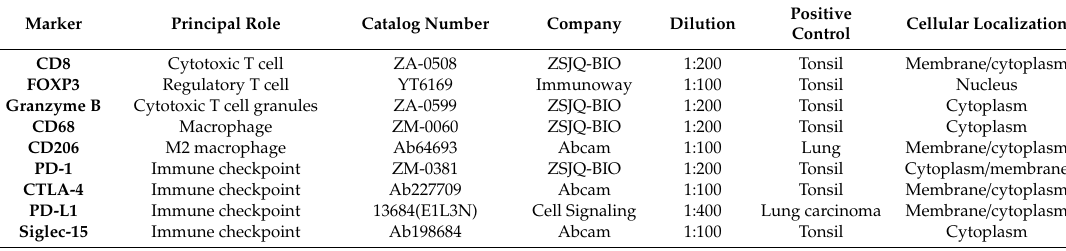
Table 5. Antibody characteristics and used protocol for whole tissue IHC.